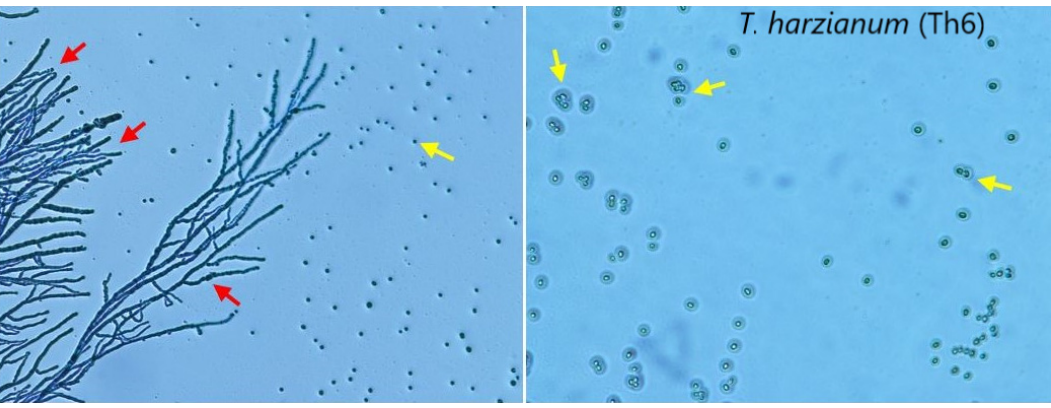
Figure 5. The conidiophores (red arrows) and conidia (yellow arrows) of the Th6 strain.